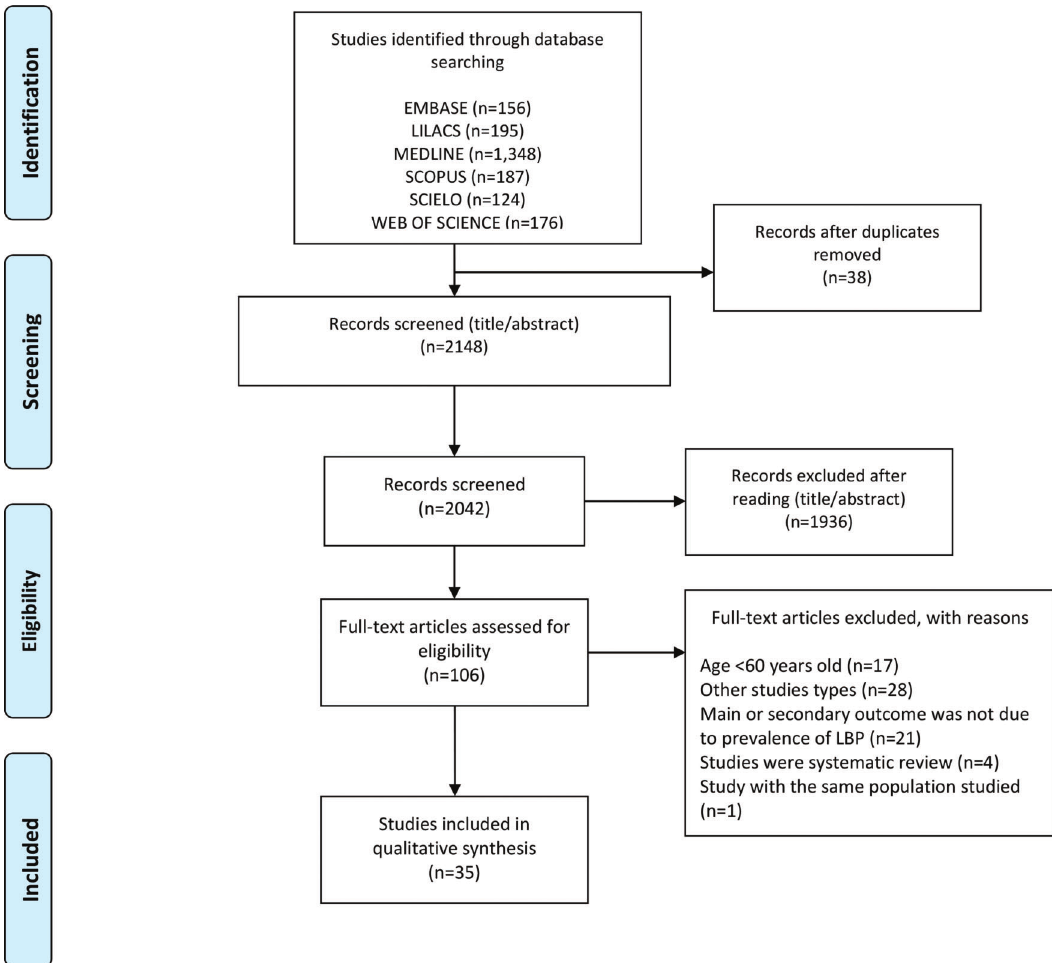
Figure 1 - Flowchart of the included